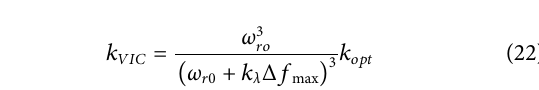
FIGURE 6 | Block diagram of virtual inertial control based on fuzzy